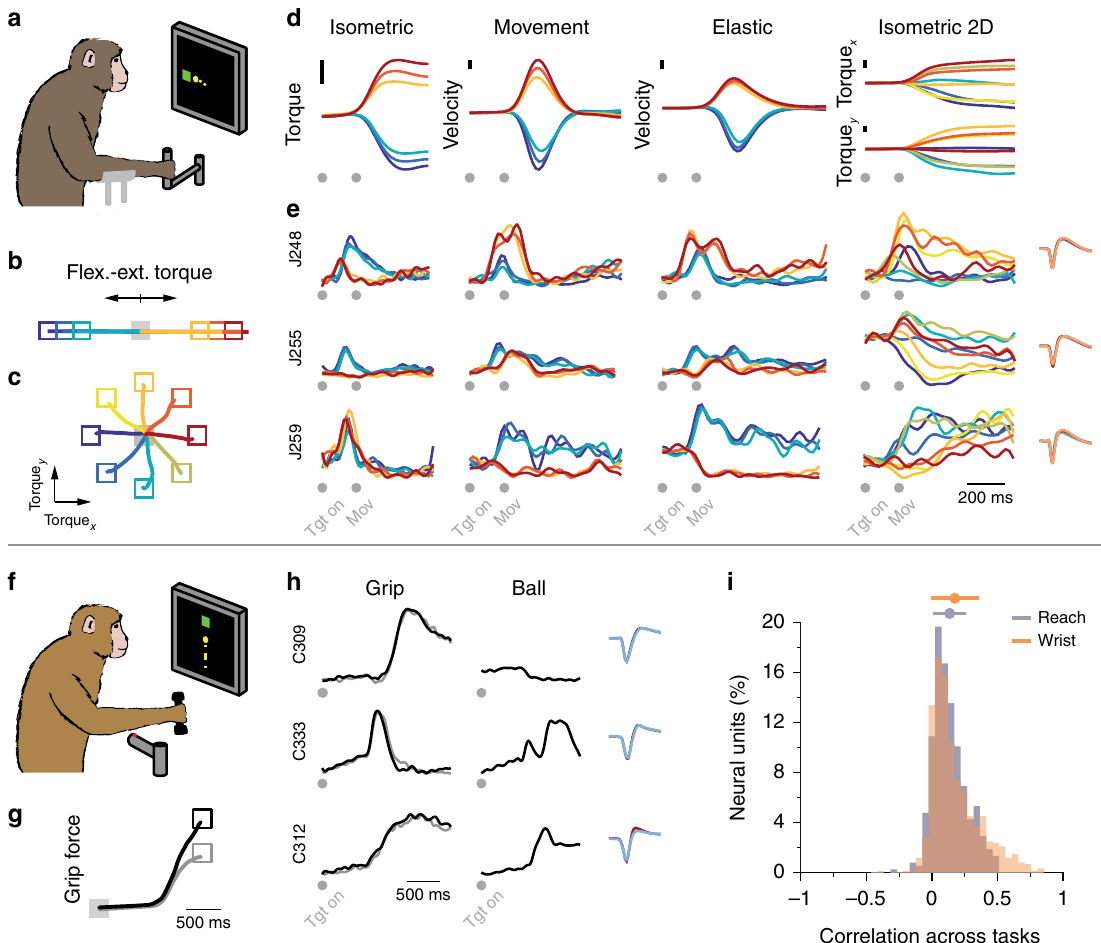
Fig. 2 Tasks and recordings. a The wrist isometric center-out task. Torque trajectories to acquire each target (colored squares) during the 1-D isometric ( b ) and 2-D isometric ( c ) tasks. d Exerted wrist torque or movement to acquire each target. e Three neural units illustrate the variety of activity patterns across units, and how these patterns change across tasks. Right inset: overlaid action potential waveform for each unit across tasks; each task in a different color. Note the excellent overlap. Data for b – e are from Monkey J, averaged over all trials in one session, and colored according to target location ( b , c ; see also Supplementary Fig. 2). f The power grip task. g Grasp force trajectories to acquire each target (black or gray squares). h Three neural units illustrate the variety of activity patterns across units for the grip task, and how these patterns change in a complex manner for the ball task. Right inset: overlaid action potential waveform for each unit across both tasks; each task in a different color. Note the excellent overlap. Data for g and h are from Monkey C, averaged over all trials in one session, and colored according to target ( g ). i Correlations r between the activity pattern of each neural unit across each pair of tasks, pooled over all units, task comparisons, sessions, and monkeys for the wrist and reach-to-grasp datasets separately; top error bar: correlation mean ± s.d.; for the wrist datasets, (cid:1) r = 0.15 ± 0.19, n = 1476; for the reach-to-grasp datasets, (cid:1) r = 0.11 ± 0.13, n =